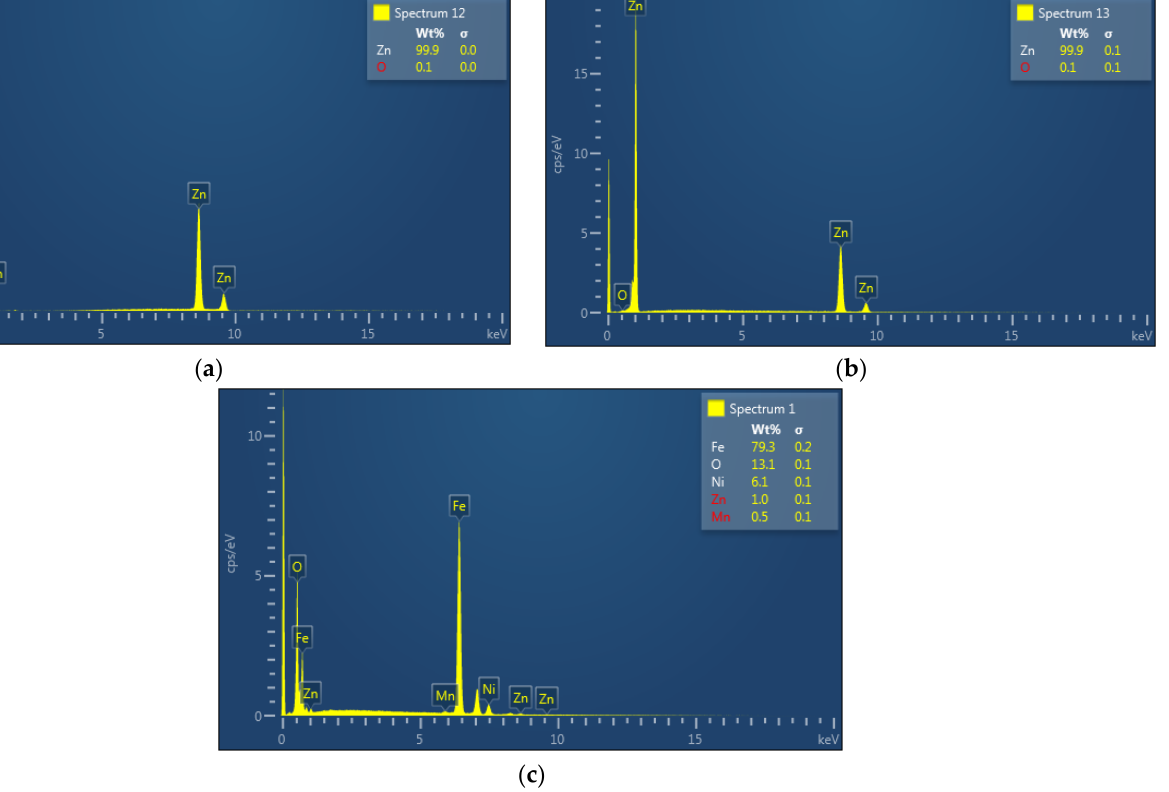
Figure 12. EDX of ( a ) zinc foil and ( b ) zinc drop at 700 °C. ( c ) EDX of the residue after evaporation at 700 °C.